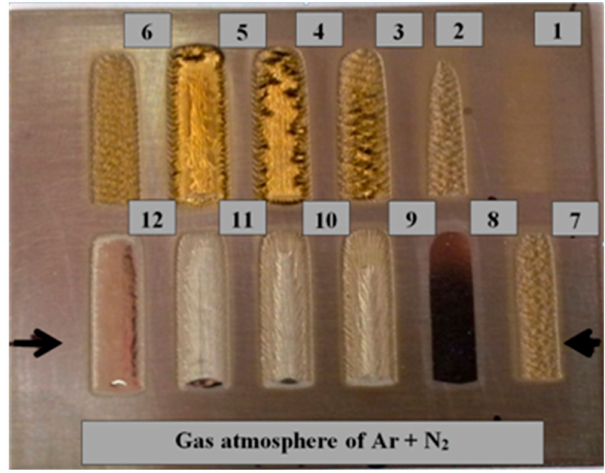
Figure 11. A view of the surface layers produced on titanium alloy Ti6Al4V by HPDDL melting in an argon and nitrogen atmosphere: bead No. 1: 800 mm / min, 0.9 kW, 70 J / mm, 100% N 2 ; bead No. 2: 600 mm / min, 0.9 kW, 90 J / mm, 100% N 2 ; bead No. 3: 400 mm / min, 0.9 kW, 136 J / mm, 100% N 2 ; bead No. 4: 200 mm / min, 0.9 kW, 270 J / mm, 100% N 2 ; bead No. 5: 400 mm / min, 1.8 kW, 270 J / mm, 100% N 2 ; bead No. 6: 400 mm / min, 1.2 kW, 180 J / mm, 100% N 2 ; bead No. 7: 400 mm / min, 0.8 kW, 120 J / mm, 100% N 2 ; bead No. 8: 400 mm / min, 1.8 kW, 270 J / mm, 100% Ar; bead No. 9: 400 mm / min, 1.8 kW, 270 J / mm, 50% Ar + 50% N 2 ; bead No. 10: 400 mm / min, 1.8 kW, 270 J / mm, 60% Ar + 40% N 2 ; bead No. 11: 400 mm / min, 1.8 kW, 270 J / mm, 70% Ar + 30% N 2 ; bead No. 12: 400 mm / min, 1.8 kW, 270 J / mm, 80% Ar + 20% N 2